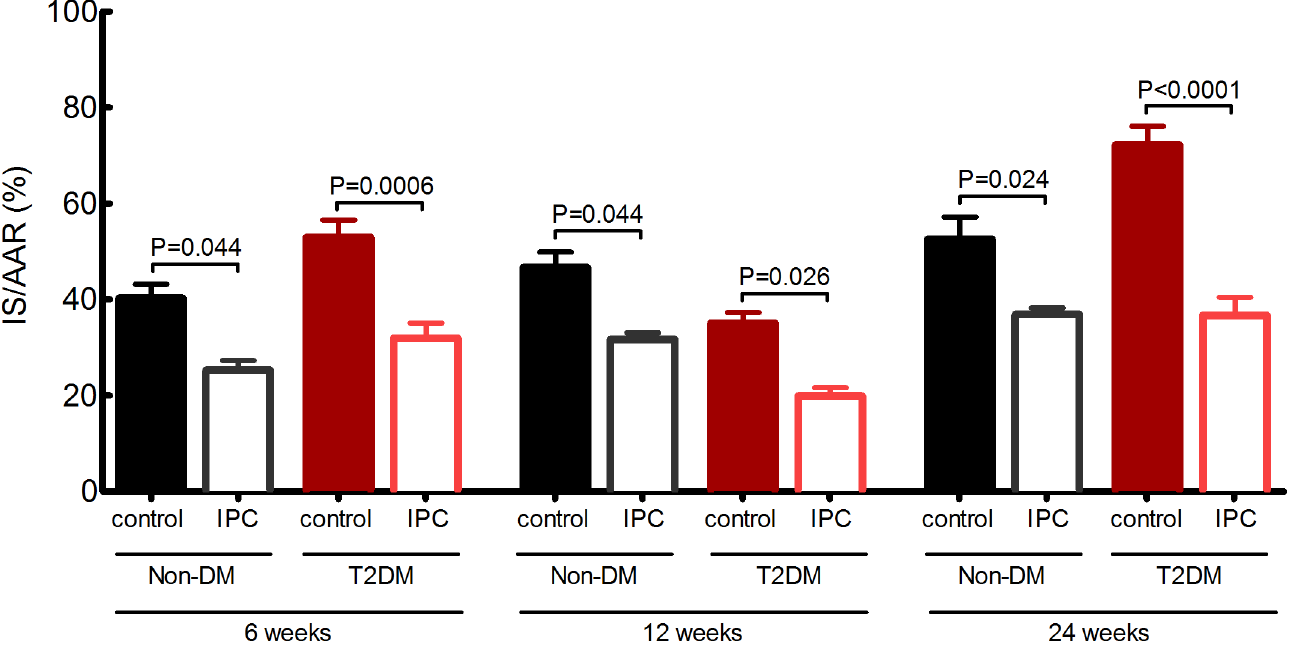
Fig 2. Infarct size. Infarct size as a ratio of area at risk in 6-, 12- and, 24-week-old non-DM rats (heterozygote (fa/+)) and DM ZDF rats (homozygote (fa/fa)) treated with control or IPC protocol. P-values are post hoc analysis between groups of interest. Data are mean ± SEM (n = 8–11).